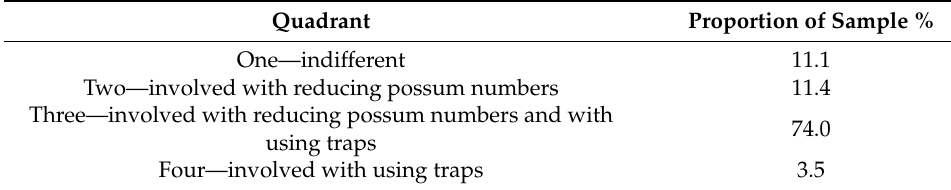
Table 1. I 3 classification.